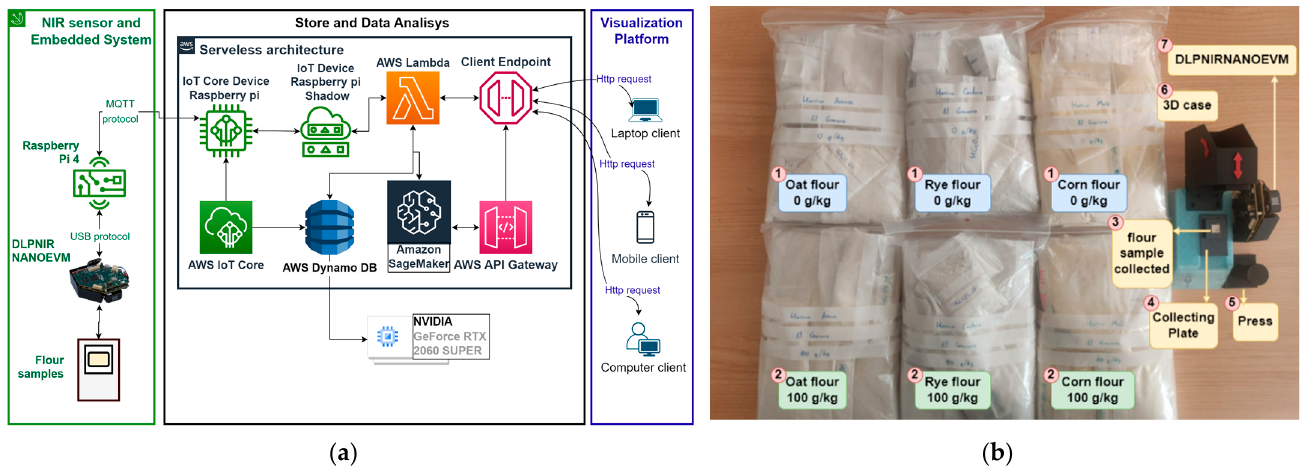
Figure 1. Software architecture, hardware, flour samples, and 3D mechanical system used. ( a ) Serverless architecture. ( b ) Flour samples, NIRS sensor, and IoT prototype portable solution.